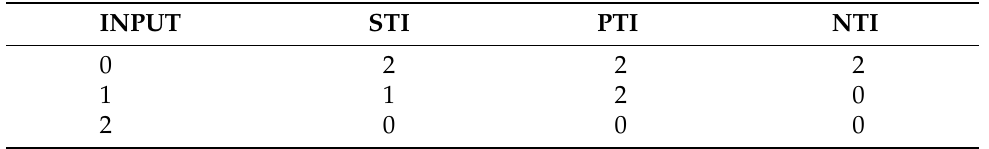
Table 2. Truth table of ternary